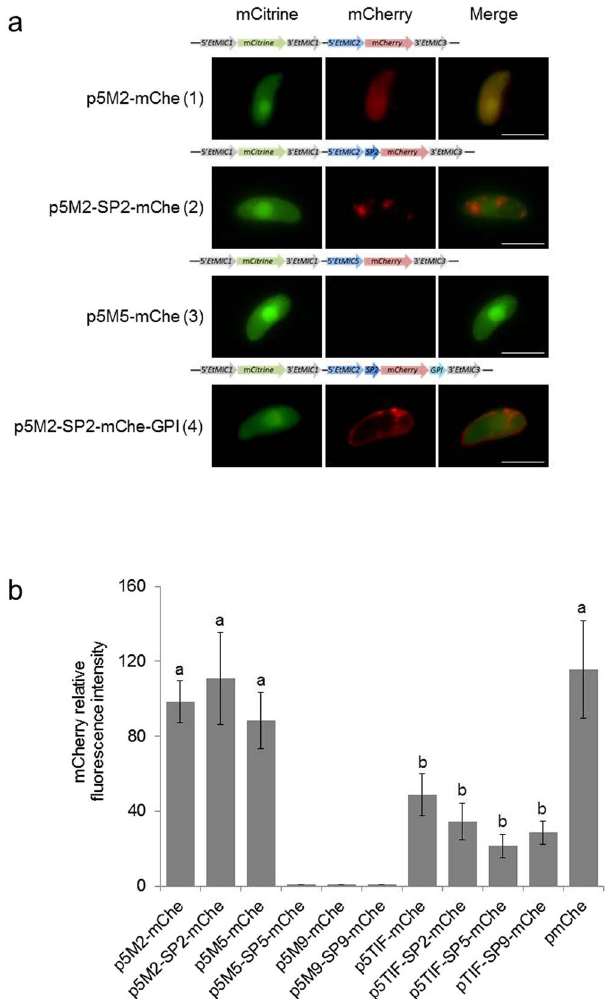
Figure 1. Study of E. tenella sporozoites transiently transfected with different plasmids and incubated with MDBK cells for 24 h (41 °C, 5% CO 2 ). ( a ) Fluorescent patterns observed after transfection with: (1) p5M2-mChe plasmid (Table 2), mCherry was observed in the cytosol; (2) p5M2-SP2-mChe plasmid (Table 2), mCherry was observed as vesicles in the cytoplasm; (3) p5M5-mChe plasmid (Table 2), mCherry not observed; (4) p5M2-SP2-mChe-GPI plasmid (Table 2), mCherry was observed on the sporozoite surface. mCitrine was always observed in the cytosol of the transfected sporozoites. The plasmids constructs for each transfection are displayed above each panel. Bars represent 5 µ m. ( b ) Relative fluorescence intensity – values between 0 (pure black) and 255 (pure white) – of mCherry analysed by Image J of sporozoites transfected with the different plasmids; a and b indicate different significances (p < 0.05; one-way ANOVA with post hoc Bonferroni